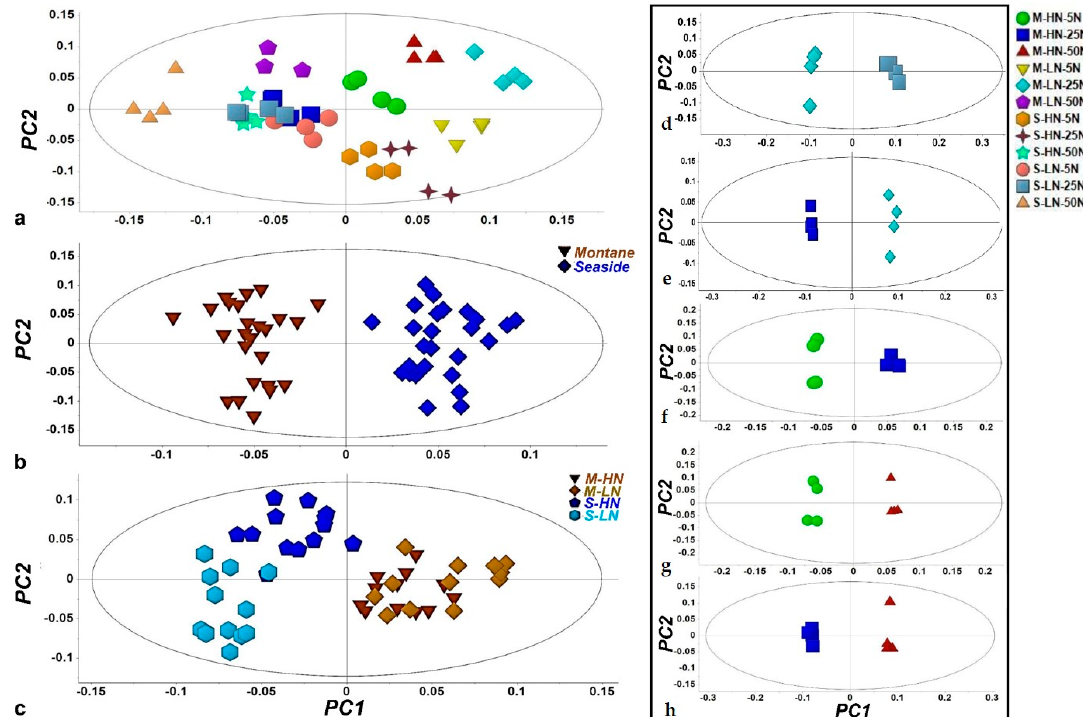
Figure 2. Orthogonal partial least squares-discriminant analysis (OPLS-DA) score plot for the recorded GC/EI/MS profiles of Cichorium spinosum ( stamnagathi ) leaves ( A ) for all of the examined treatments. ( B ) Pairwise comparison between the montane (M) and seaside (S) grown under low-N supply level. ( C ) Stamnagathi plants of the montane and seaside ecotype treated with either 4 or 16 mmol L − 1 (denoted as Low-N and High-N, respectively). The following pairwise comparisons were performed: ( D ) S vs. M under low-N supply and medium NH 4 /total-N fraction (25%), ( E ) High-N vs. Low-N in the montane ecotype grown under medium NH 4 /total-N fraction (25%), ( F ) 5% vs. 25% NH 4 /total-N fraction under high-N conditions for the montane ecotype, ( G ) 5% vs. 50% NH 4 /total-N fraction under high-N conditions for the montane ecotype, and ( H ) 25% vs. 50% NH 4 /total-N fraction under high-N conditions for the montane ecotype. The ellipse represents the Hotelling’s T2 with 95% confidence interval. In total, 12 biological replications were performed per treatment, every 3 of which were pooled to provide a pooled sample. Four pooled samples and one quality control sample were analyzed per treatment (PC: principal component).